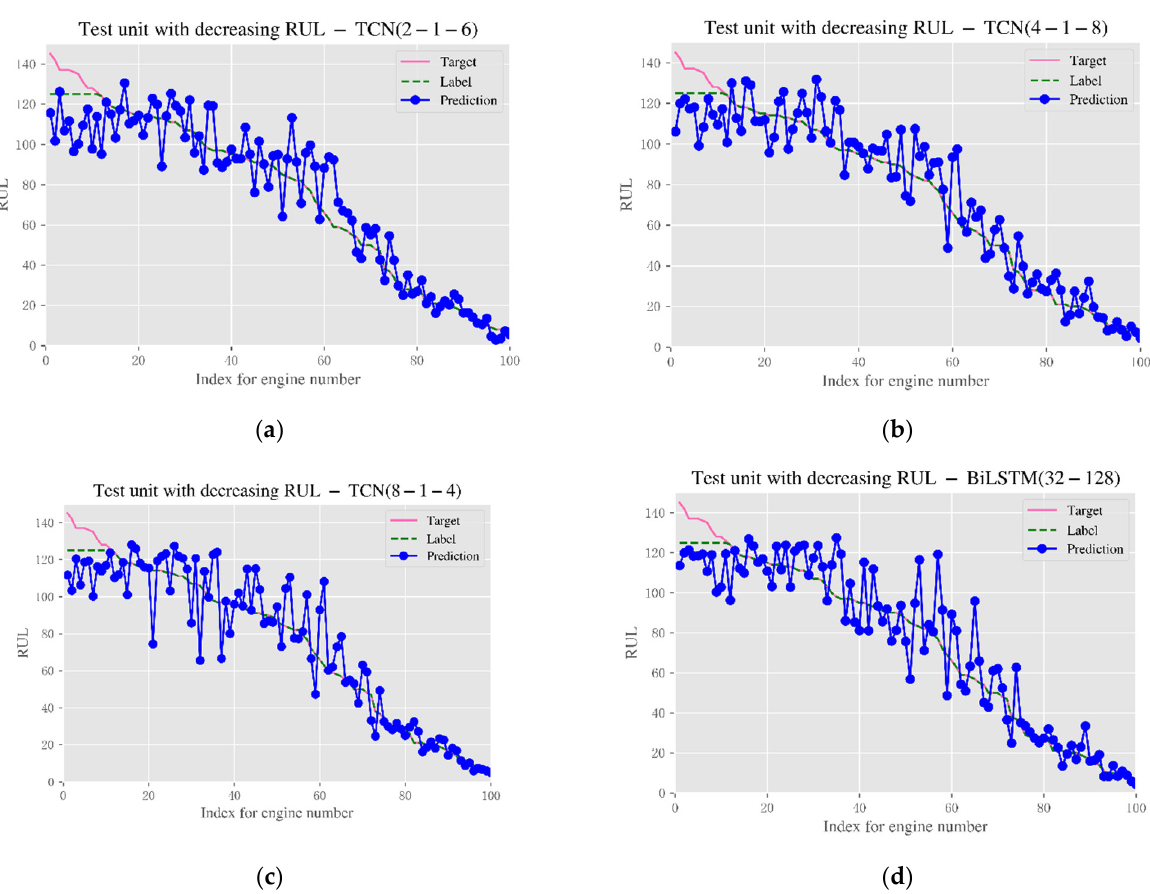
Figure 12. RUL prediction results of 100 engines under different combinations. ( a ) TCN (2-1-6);